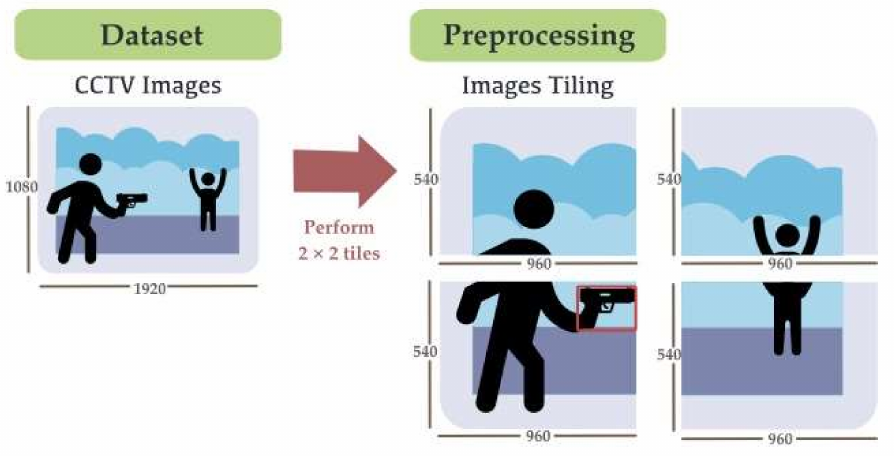
Figure 8. Image tiling method.